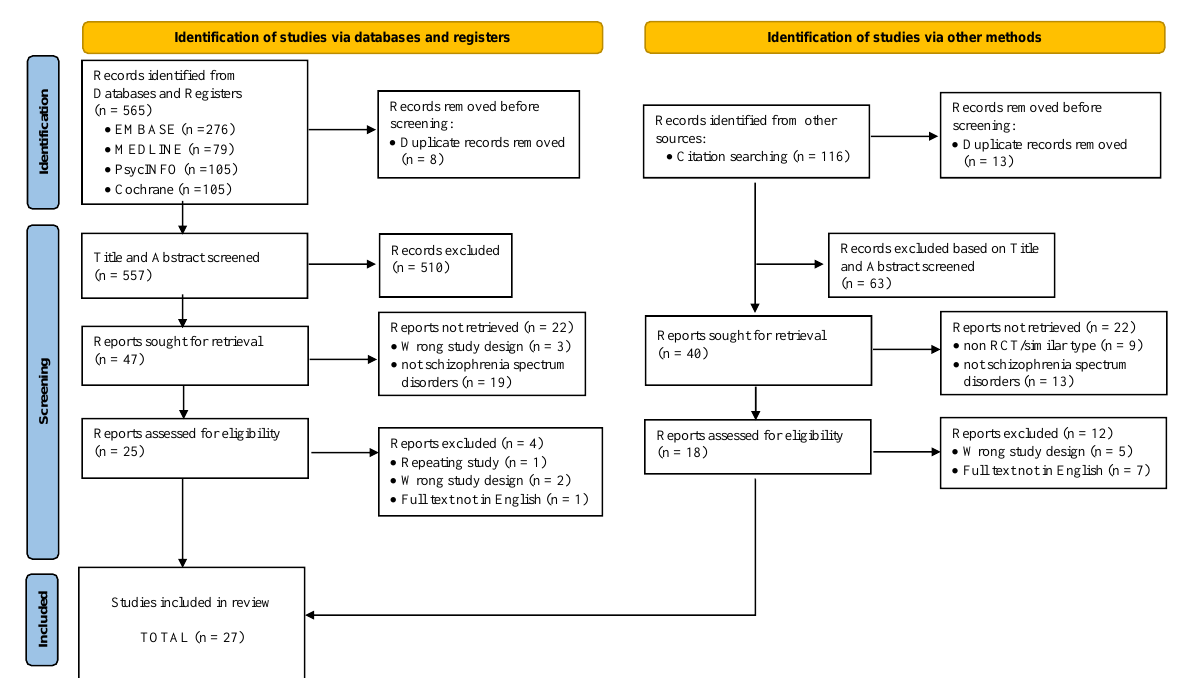
Figure 1. Flowchart based on the PRISMA 2020 statement [36] that describes the movement of information through the various stages of conducting this systematic review.